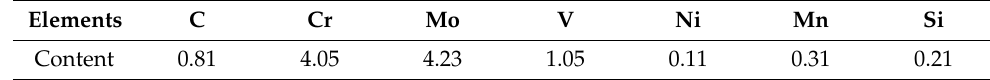
Table 2. Chemical compositions of M50 steel (wt.%).